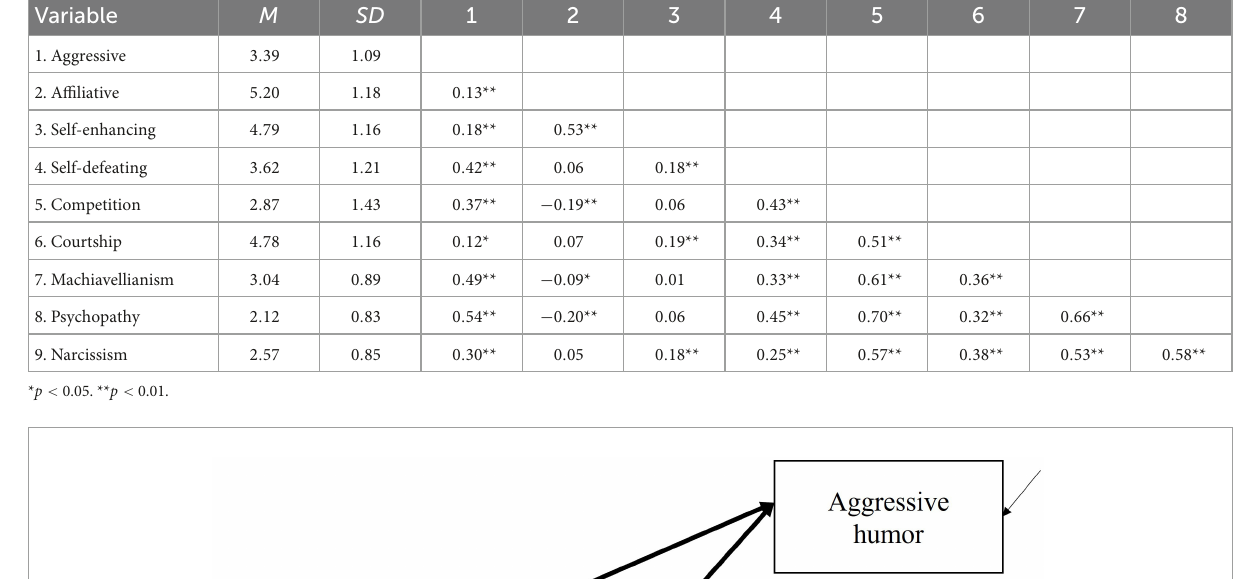
TABLE 1 Descriptive statistics and intercorrelations.